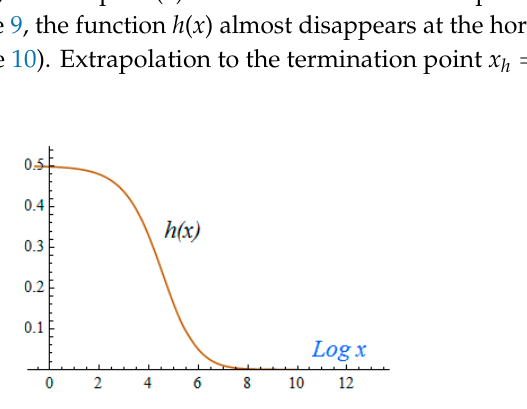
Figure 10. Function h ( x ) in the interval (